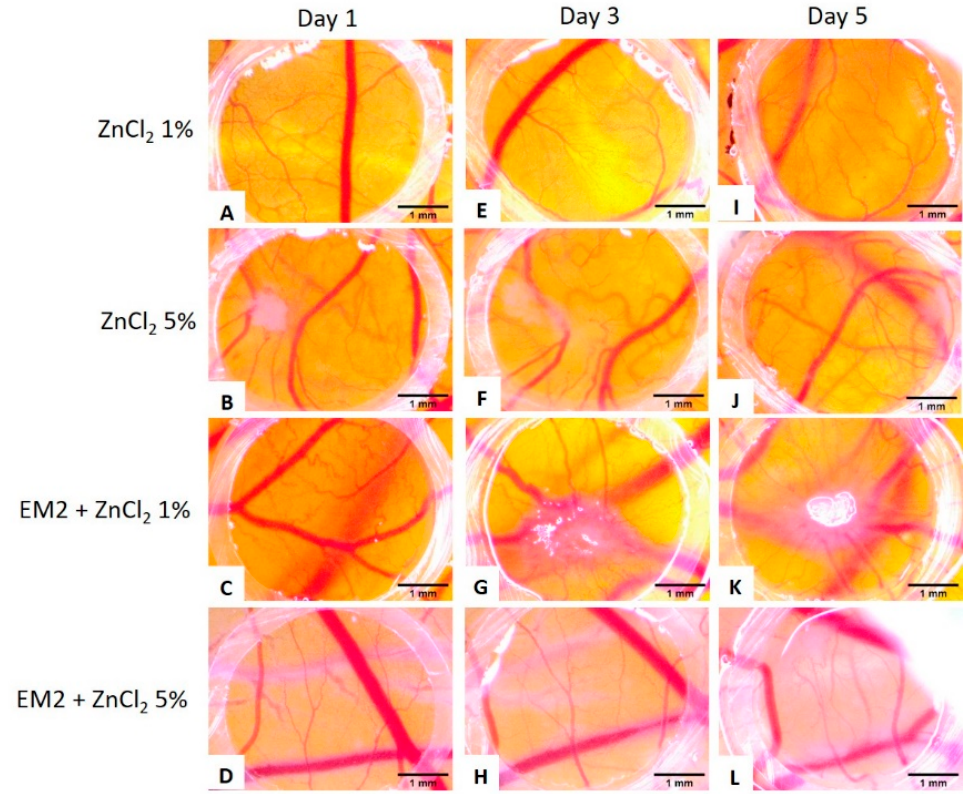
Figure 6. Normal chick chorioallantoic membrane-angiogenesis evaluation of ZnCl 2 and of EM2 + ZnCl 2 ; suggestive stereomicroscopic images were registered on day 1 ( A , B , C , D ), 3 ( E , F , G , H ) and 5 ( I , J , K , L ) of the experiment. EM2 100 µM and ZnCl2 1% and 5% ( m / m ) were tested.